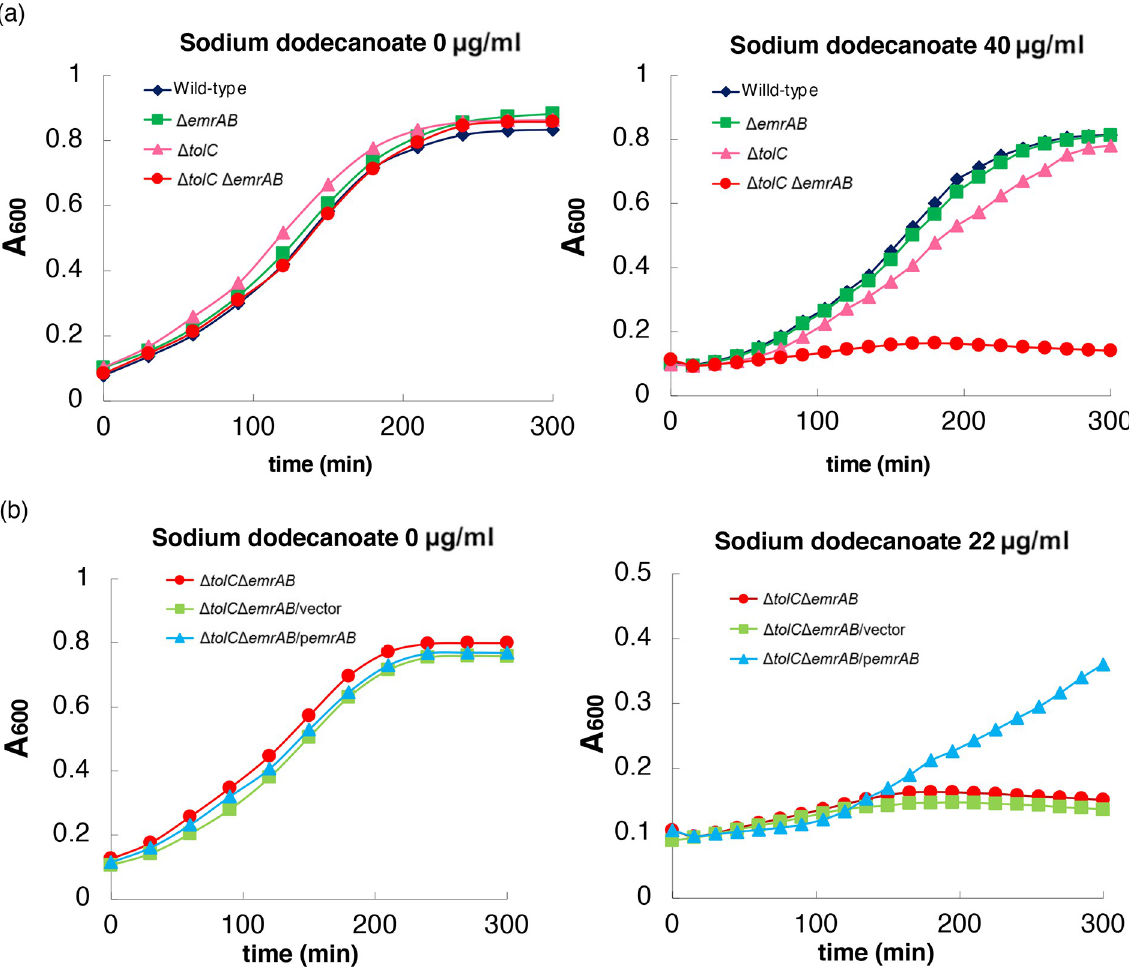
Fig 3. Effects of tolC and emrAB on the growth of Salmonella enterica in the presence of sodium dodecanoate. (a) Growth of the wild-type strain, emrAB , tolC and tolC emrAB mutants with or without sodium dodecanoate. (b) Growth of tolC emrAB mutant, tolC emrAB harbouring vector or p emrAB with or without sodium dodecanoate. Shown is the result of one of the three experiments, which gave similar